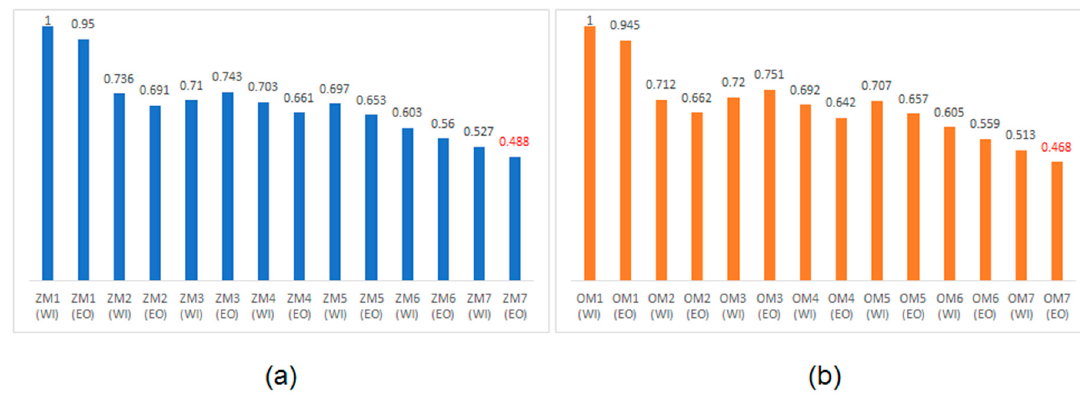
Figure 6. Normalized power-cycle time product (PCTP) of QDI array multipliers corresponding to: ( a ) RTZ handshaking, and ( b ) RTO handshaking. The red data labels in ( a , b ) represent the optimum PCTP values, reflecting the best (proposed) array multiplier designs corresponding to RTZ and RTO handshaking.